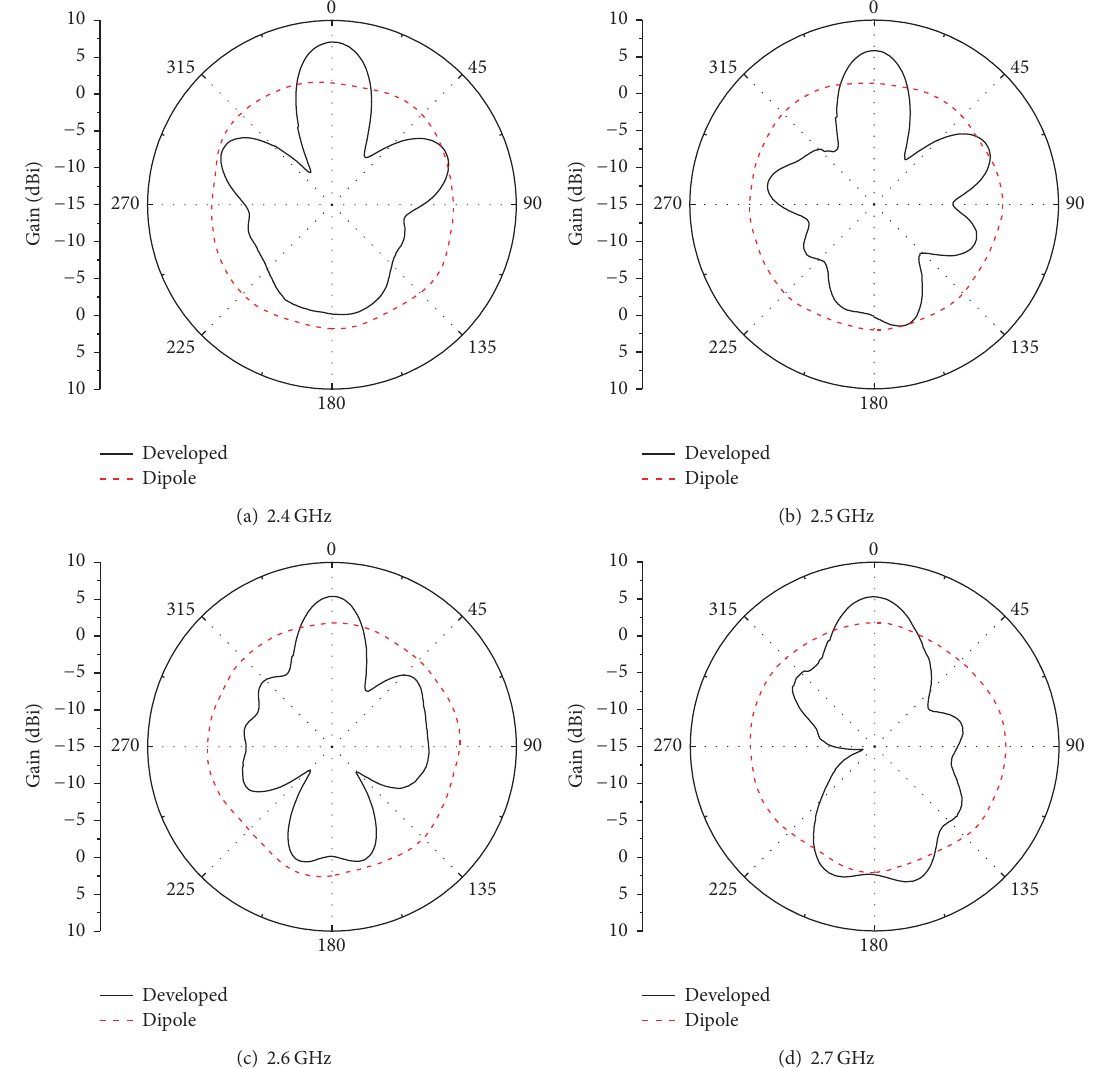
Figure 14: High-gain mode radiation patterns of the developed antenna from 2.4 GHz to 2.7 GHz.